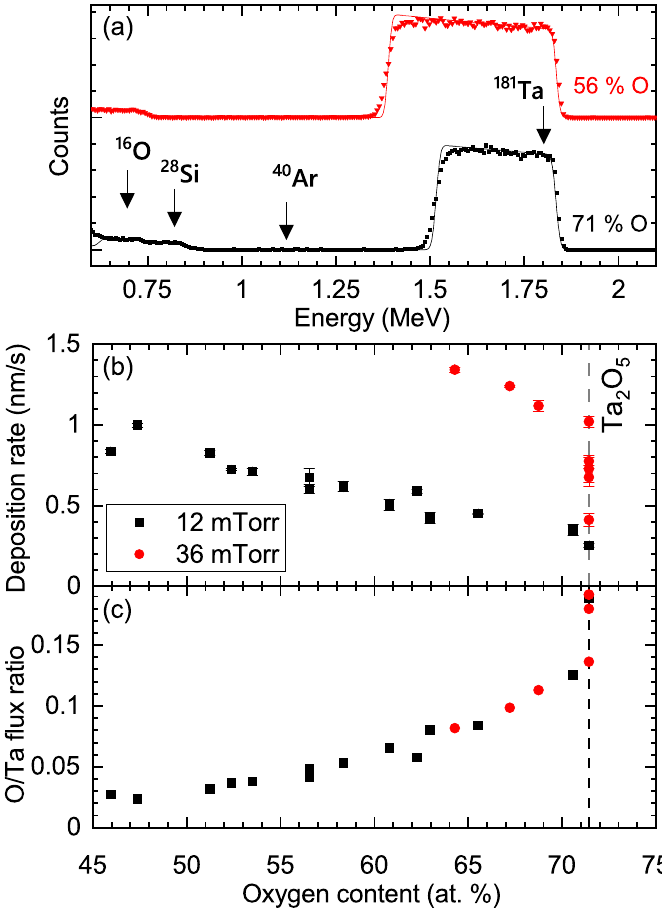
Figure 1. ( a ) Rutherford backscattering spectra from two representative TaO x films (with x of 0.56 and 0.71) on Si substrates with a 200 nm thick thermal oxide layer on top. Symbols are data points, solid lines are results of simulations using RUMP. For clarity, spectra are vertically offset, and only every fifth experimental point is depicted. The buried 28 Si edge and surface edges of 16 O, 40 Ar and 181 Ta are denoted by arrows. ( b ) The deposition rate versus O content in films for the two pressures of the Ar-5%O 2 working gas mixture studied, thus, demonstrating how effective stoichiometry control can be achieved by changing the deposition rate. Error bars arise from scatter in thickness measurement across the film. ( c ) The ratio of O and Ta atomic flux incident upon the substrate, demonstrating that film stoichiometry is limited by O availability up to the formation of stoichiometric Ta 2 O 5 , marked by a vertical dashed line. Due to the higher oxygen availability at 36 mTorr working gas pressure, most samples produced were stoichiometric Ta 2 O 5 with 71.4 at.% oxygen content, and several such overlapping points are omitted for